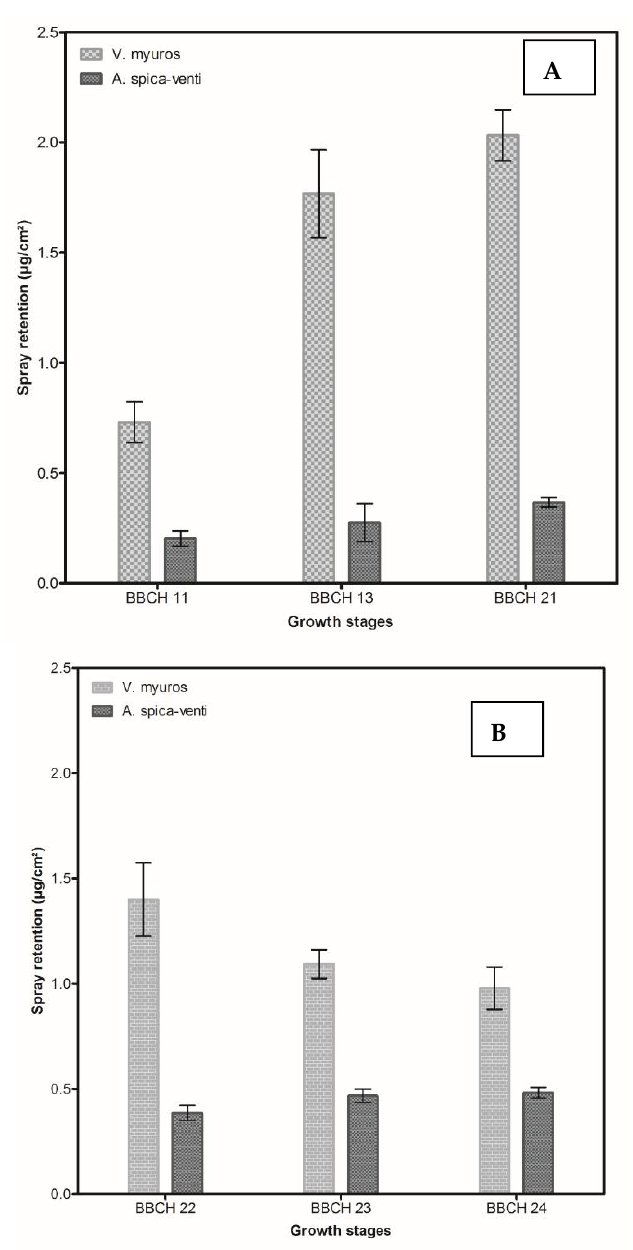
Figure 2. Retention of the glyphosate spray solution on Vulpia myuros and Apera spica-venti in glasshouse ( A ) and outdoor natural conditions ( B ). Data from two glasshouse experiments are pooled in figure ( A ).